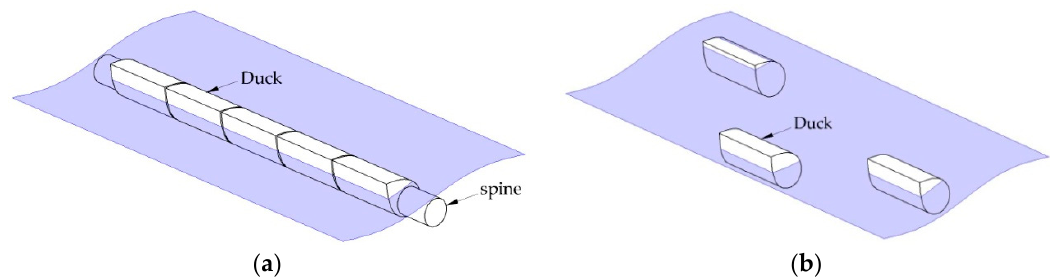
Figure 1. Configuration of Ducks: ( a ) spine-connected Ducks; ( b ) solo Ducks.